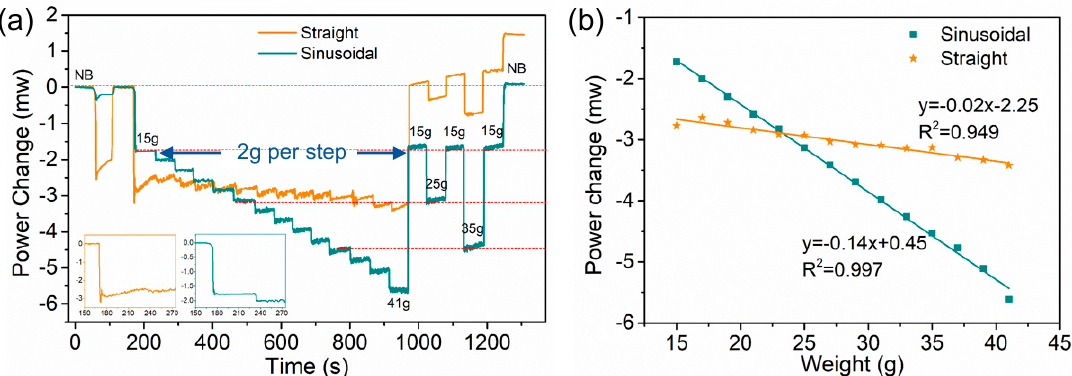
Figure 6. ( a ) The effect of weight change in the object to the reflected power change at the operation wavelength of the embedded (sinusoidal and straight) FBG in the soft gripper; ( b ) relationship between optical power change and object weight.